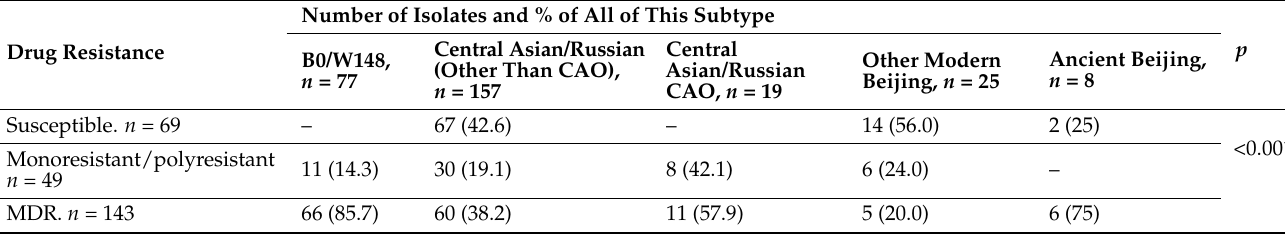
Table 5. Drug resistance structure of the studied Beijing